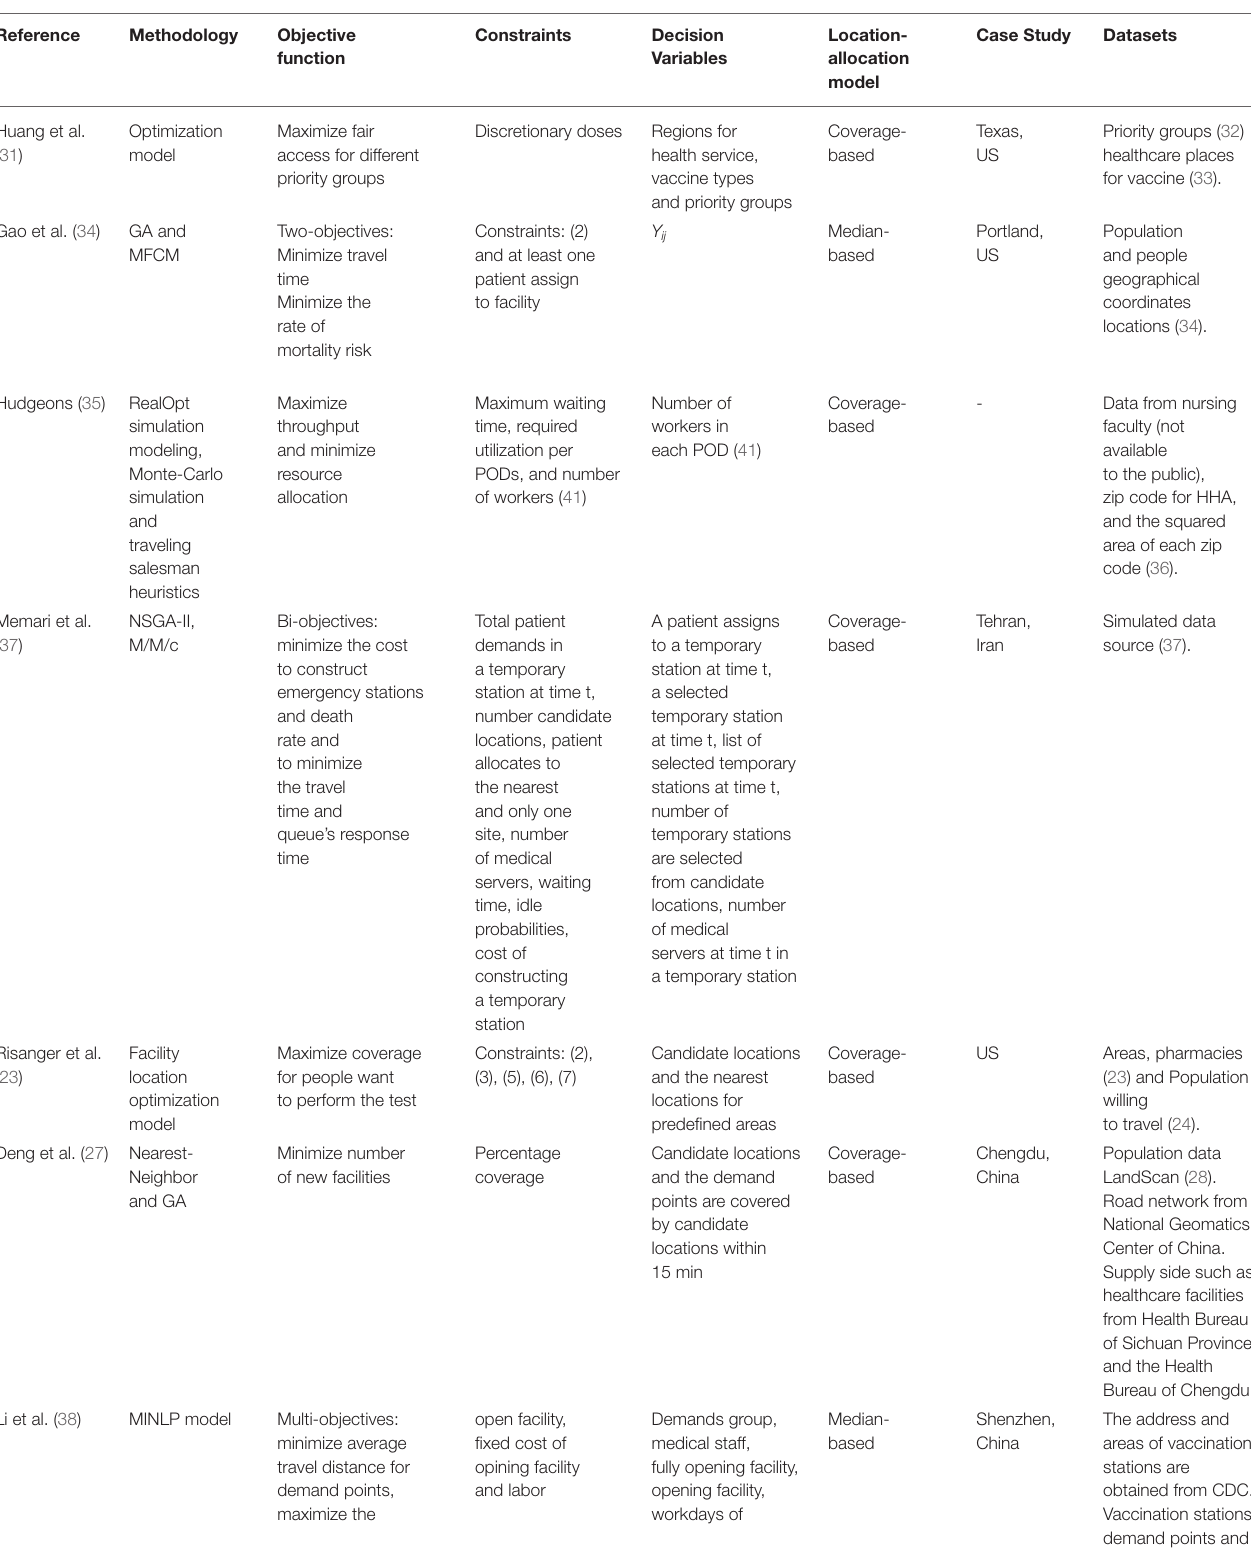
TABLE 5 | Summary of location-allocation solutions for PODs during public health